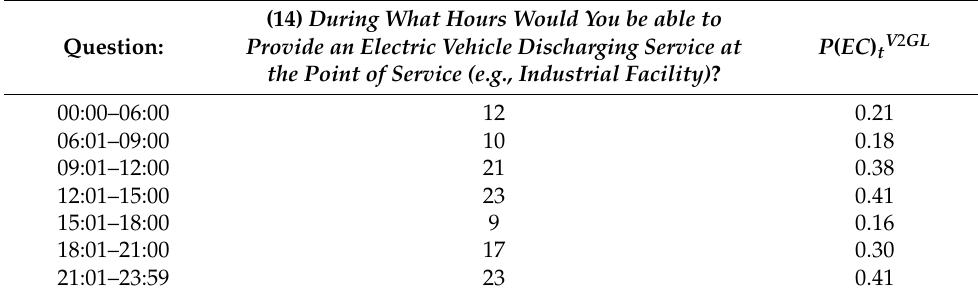
Table 2. Distribution of responses to the question regarding the hours of potential V2G service provision location of EndUs and calculated probability P ( EC ) tV 2 GL